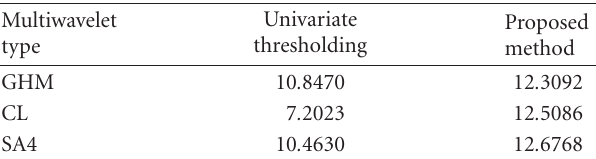
Table 1: SNRs of the denoised image which is preprocessed with approximation prefiltering.